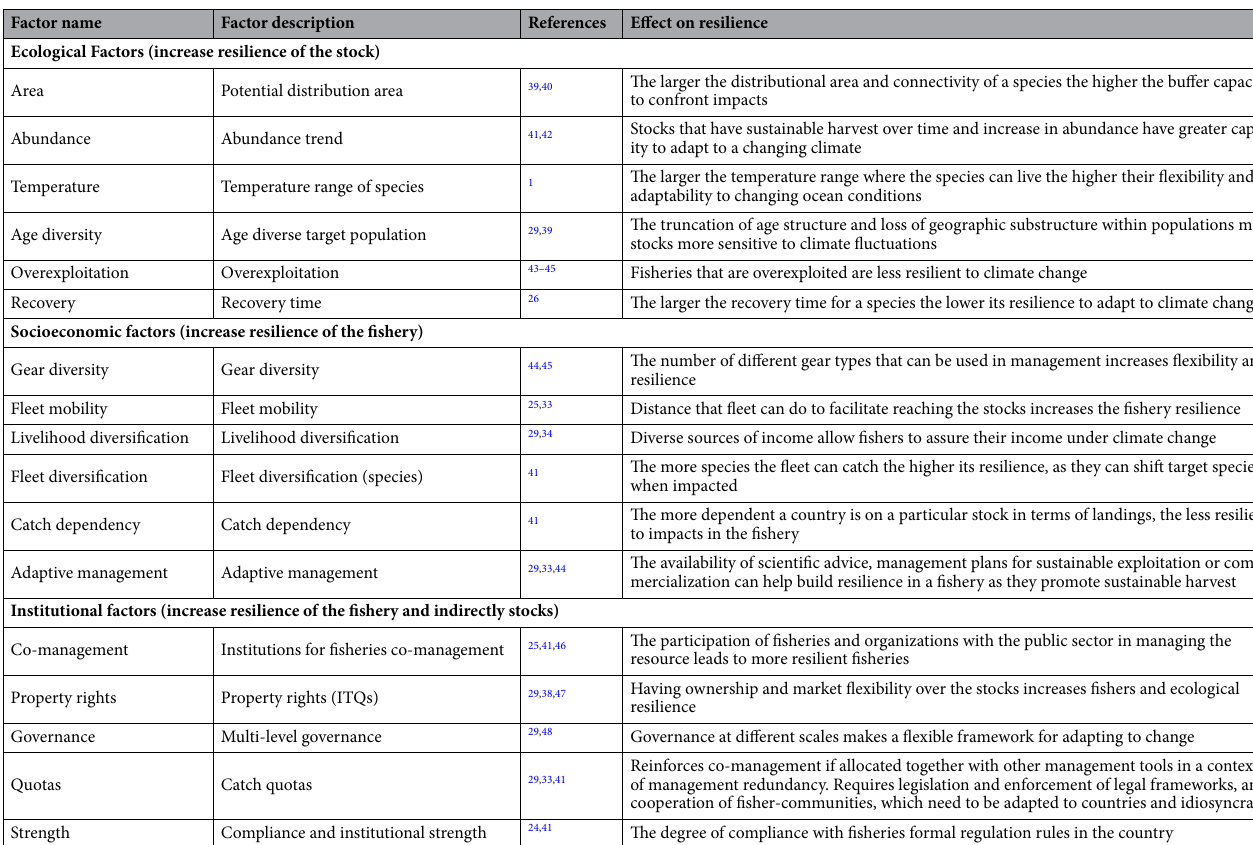
Table 1. List of resilience factors. Fisheries characteristics and management practices that have been seen to increase/decrease the resilience of a fishery to climate